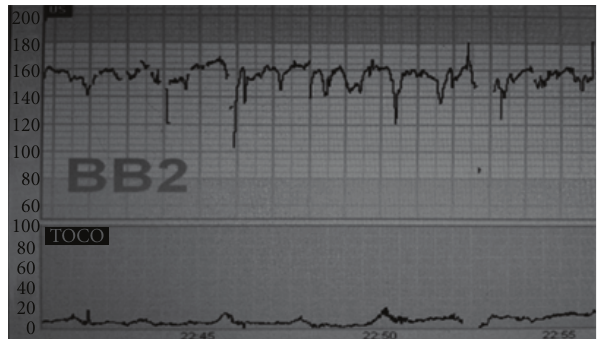
Figure 2: CTG of a fetus at 26 weeks of gestation: note higher baseline heart rate, apparent reduction in baseline variability, and “shallow” variable